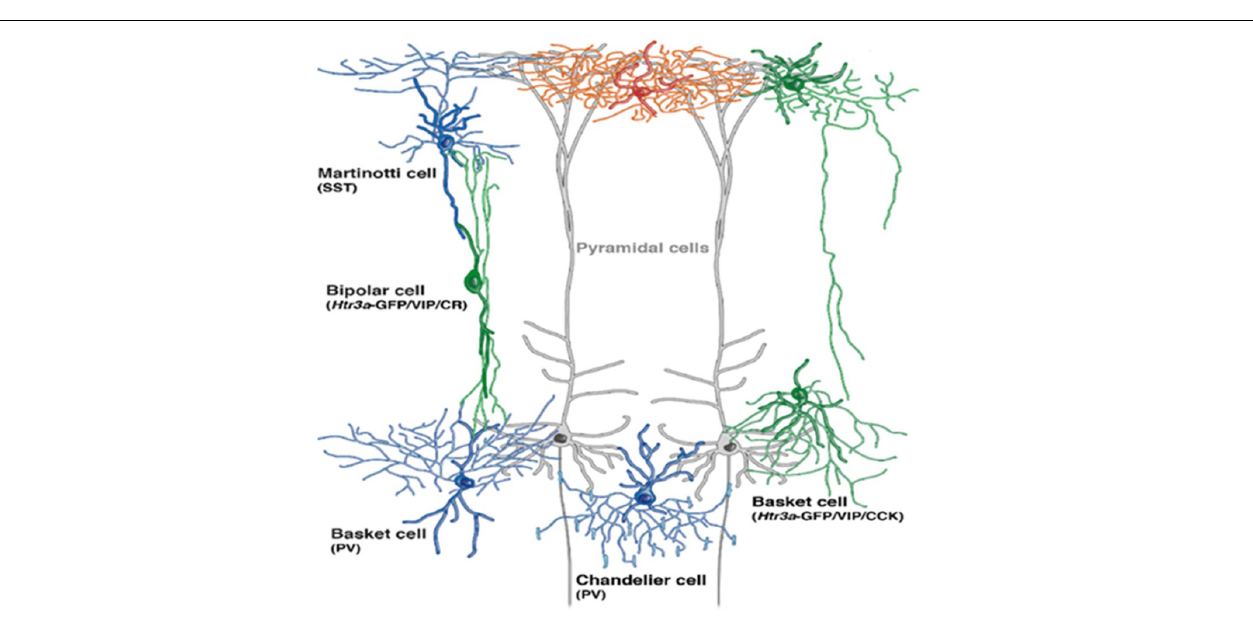
FIGURE 2 | Depiction of GABAergic interneuron’s location within the cortex (adopted a cropped version from Niquille et al., 2018, under the terms of Creative Commons Attribution License). Gray extended cells are pyramidal cells spanning across cortical layers. Basket cells are aligned to deliver their transmissions to cell bodies of pyramidal neurons, whereas chandelier cells deliver inputs on axon initial segment (AIS) of principle